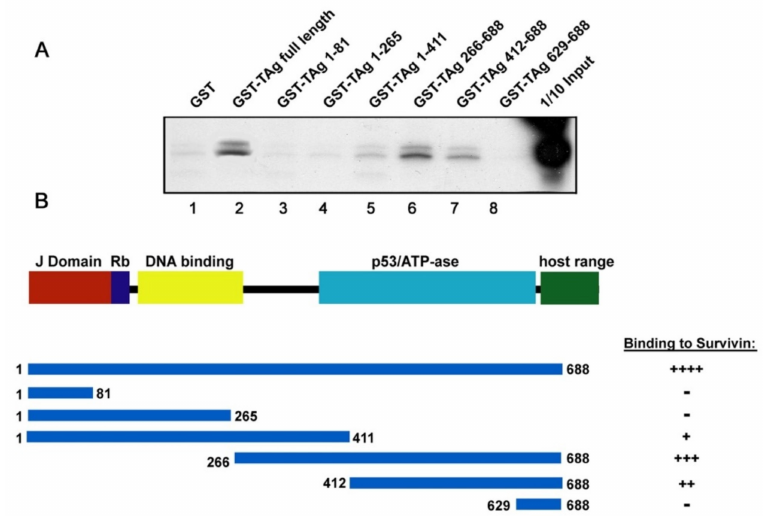
Figure 4. Survivin binds to the p53 / ATP-ase domain of JCPyV T-Antigen. A GST-pulldown assay in which [ 35 S]-radiolabeled in vitro-translated (IVT) Survivin was incubated either with GST, GST-T-Antigen full-length, or GST-T-Antigen deletion mutants bound to glutathione beads, was